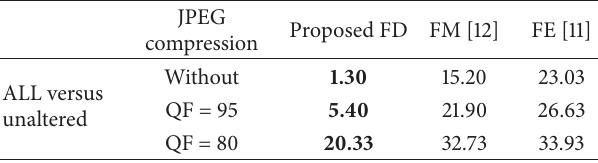
Figure 8: The 2D feature of FD (after LDA) estimated from 1500 uncompressed images of BOSSRAW database. Table 4: 𝑃 𝑒 (%) of each detector on detecting “ALL” images from unaltered images. Here “without” means without applying JPEG compressionontestimages.Thebestresultisdisplayedbyboldtexts.